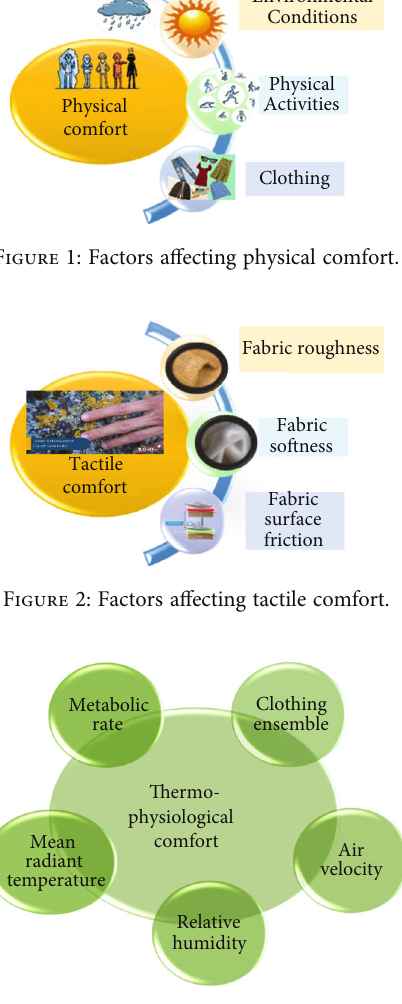
Figure 3: Factors a ff ecting thermo-physiological